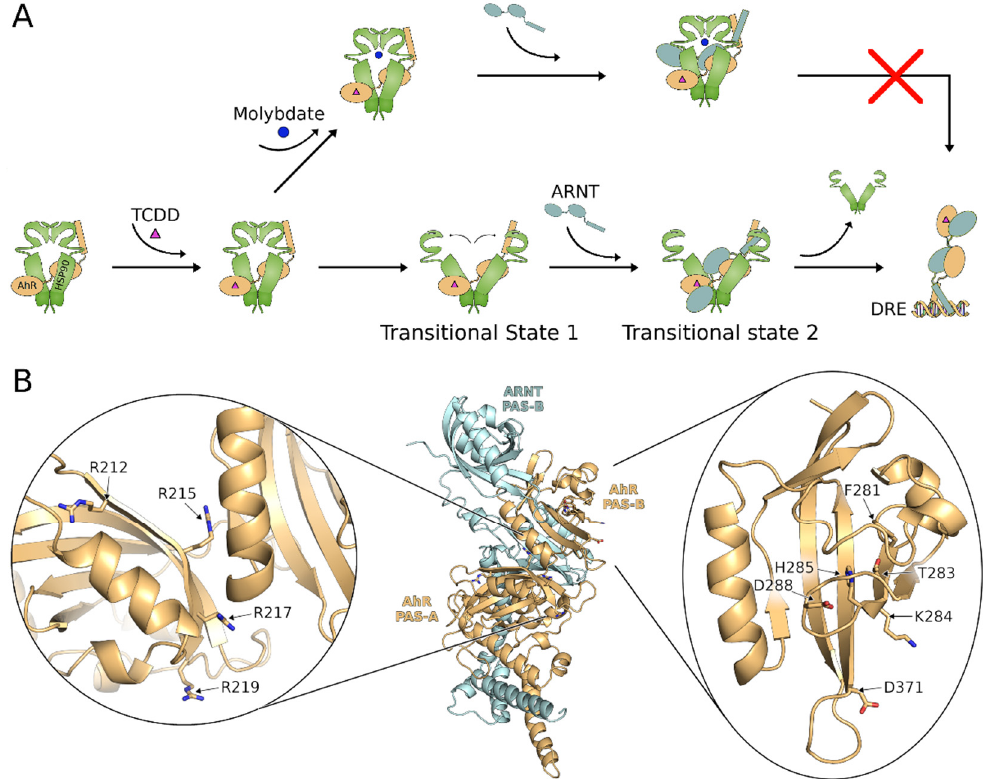
Figure 6. Multi-step mechanism of ligand-dependent AhR transformation involves interplay of hsp90 dissociation and dimerization with ARNT. ( A ) Proposed transitional mechanism of AhR transformation (details in text). ( B ). Homology model of the AhR:ARNT dimer [33] with close-ups of the AhR PASA Arg-Cys-rich region (left) and AhR PASB (right). Residues discussed in the text are represented with sticks and labeled.